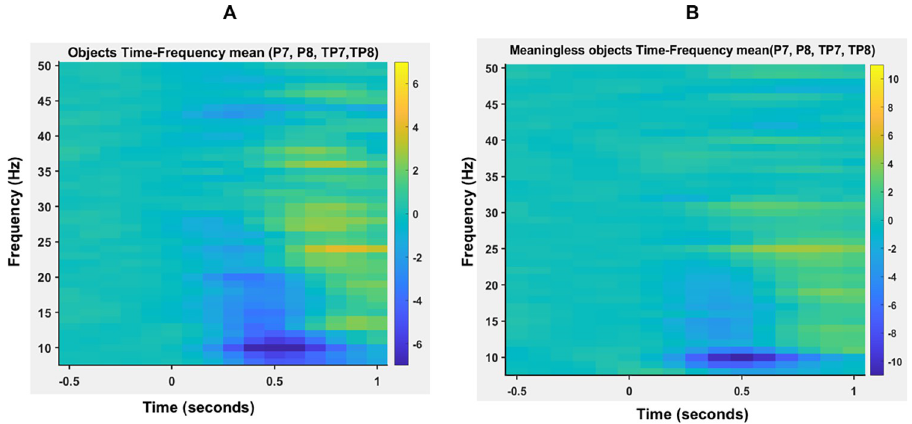
Fig 2. Frequency power spectrum averaged over four electrodes of interests (TP7, TP8, P7, P8) for object (2A) and meaningless object (2B) stimuli plotted across time.